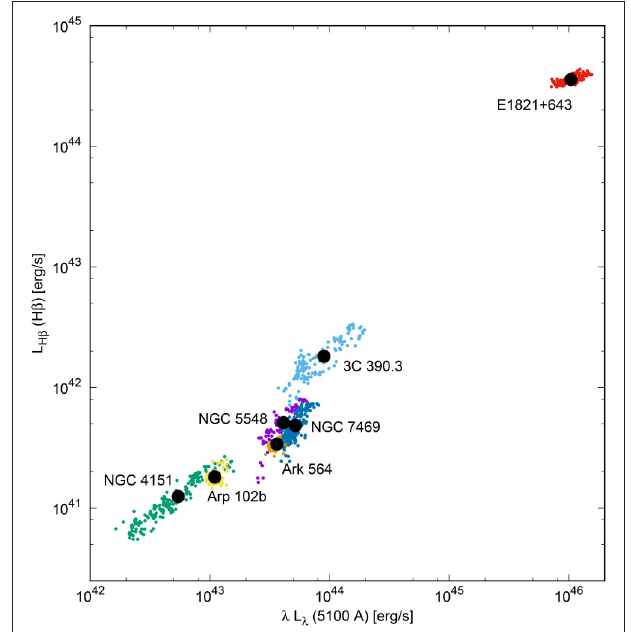
FIGURE 2 | H β line luminosity for all 7 objects vs. the continuum luminosity at 5100 Å (dots). The mean value is also shown (filled circle) with the object name denoted next to it.